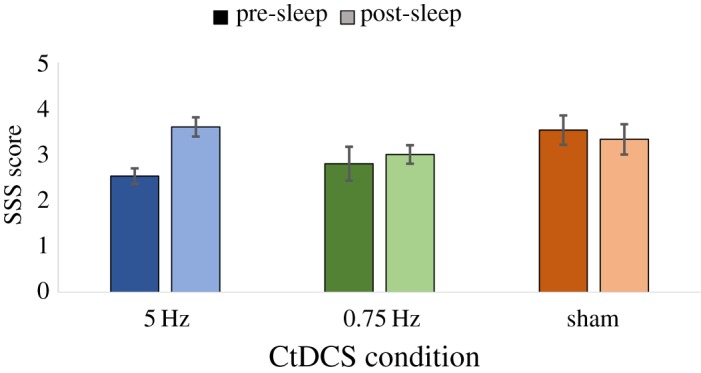
Alertness, measured by the SSS, shown before and after sleep in each CtDCS condition.